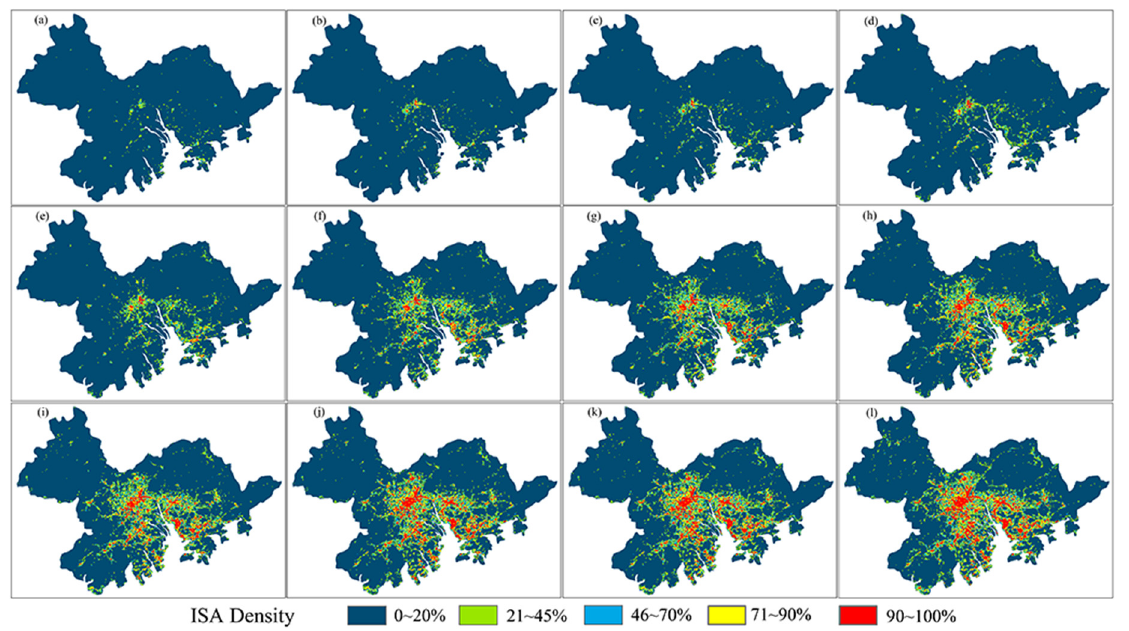
Figure 7. ISA density in each year: ( a ) 1994; ( b ) 1996; ( c ) 1998; ( d ) 2000; ( e )2002; ( f ) 2004; ( g ) 2006; ( h ) 2008; ( i ) 2010; ( j ) 2013; ( k ) 2014, and ( l ) 2016.